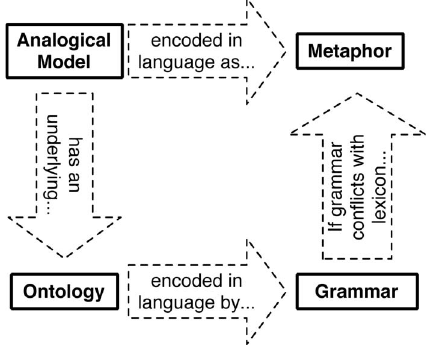
FIG. 1. A model of language